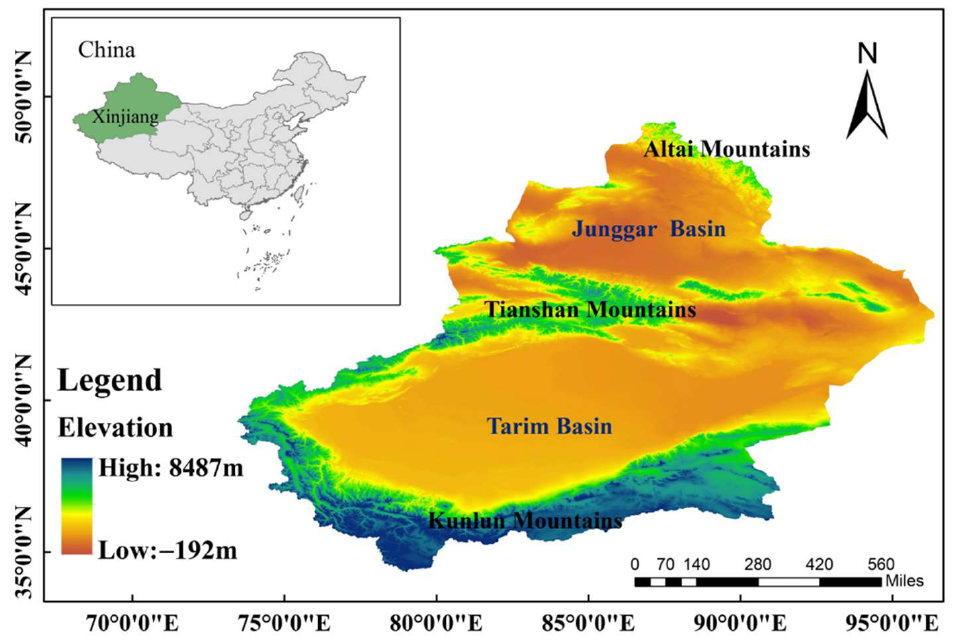
Figure 1. Map of Xinjiang, China.